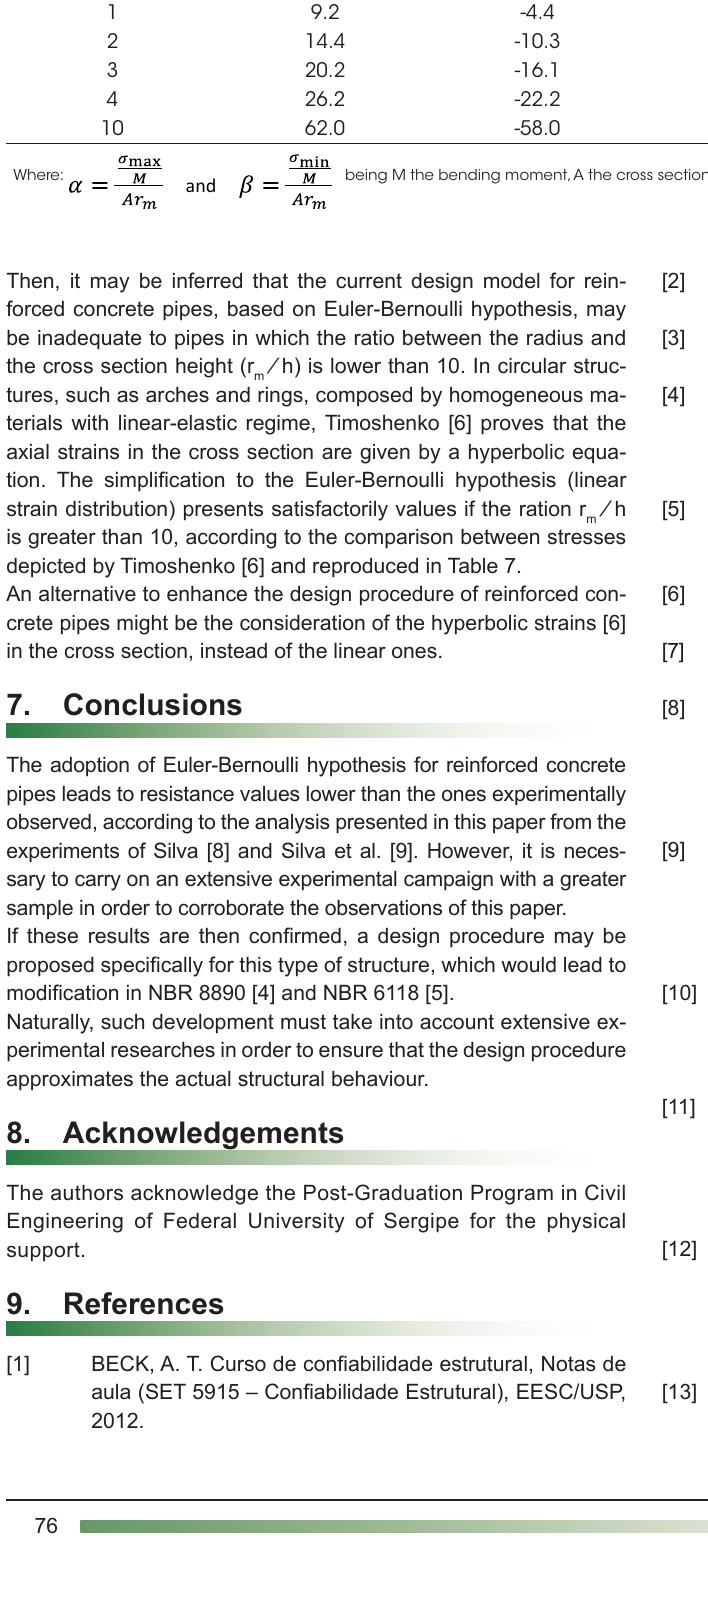
Error of S due to linear stress